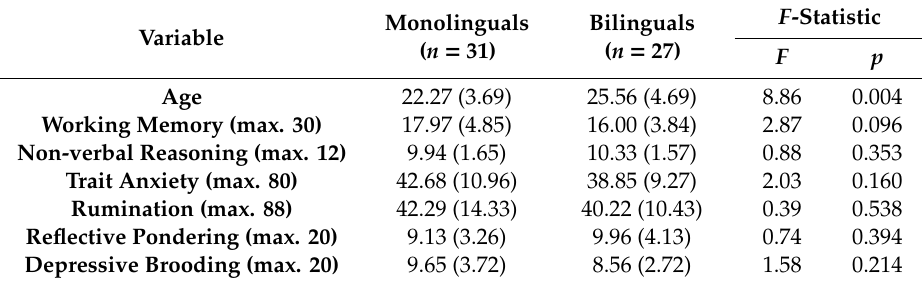
Table 2. Group means for age, working memory, non-verbal reasoning, trait anxiety, and rumination (standard deviations in brackets).